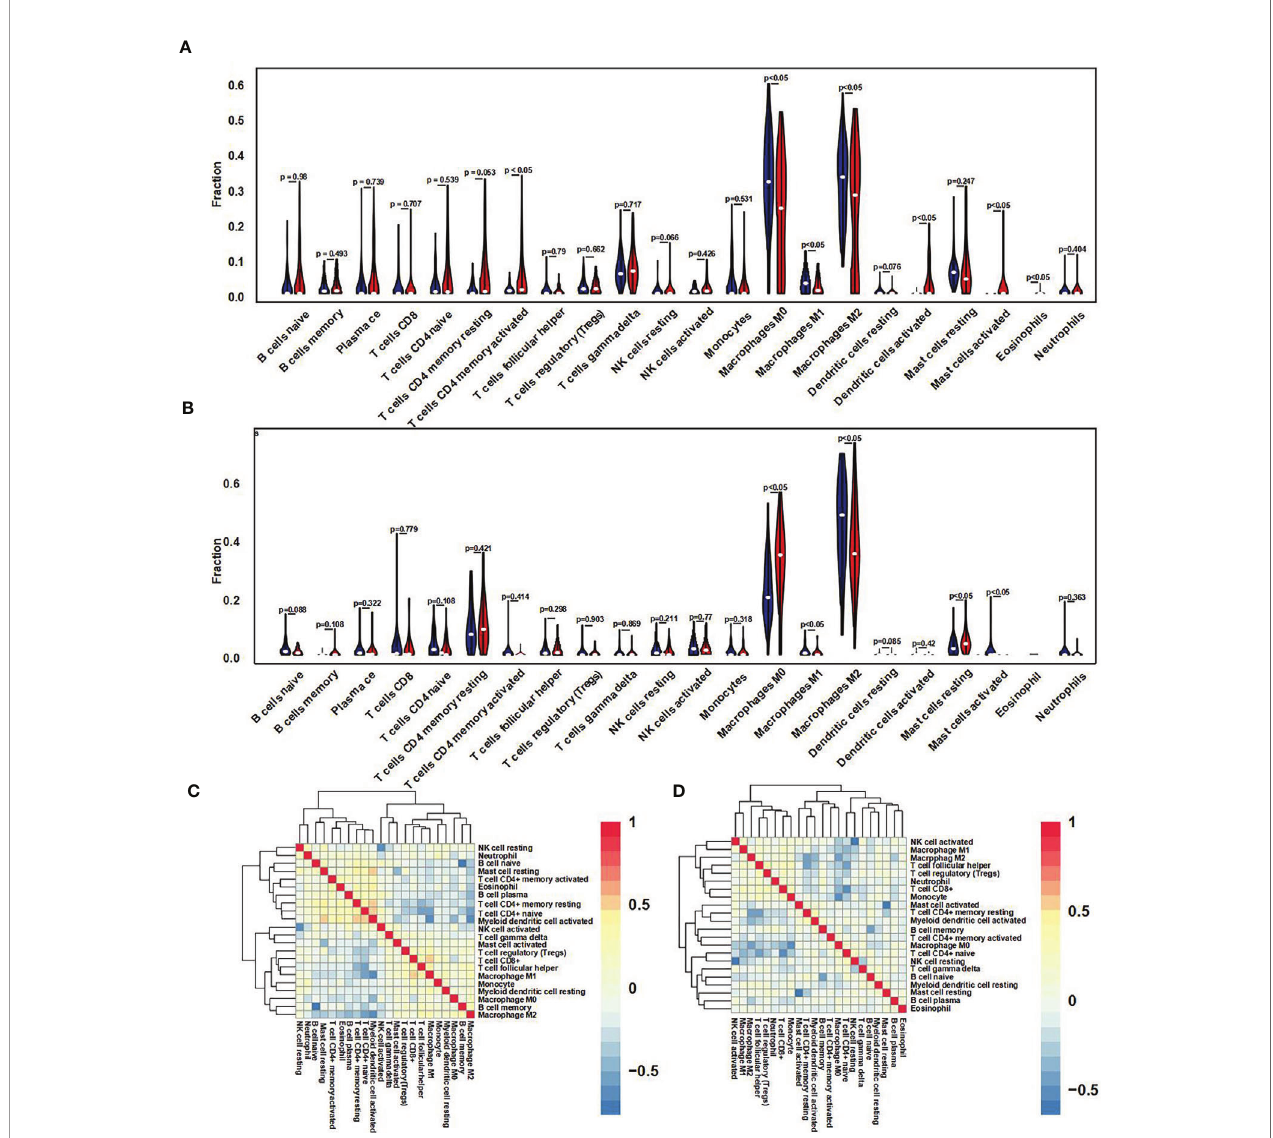
FIGURE 6 | Immune cell in fi ltration difference and correlation analysis. (A) Using the CIBERSORT package, the LM22 algorithm was used to calculate the difference in expression of 22 immune cells in the GNG12 high and low expression groups in the 103 osteosarcoma samples in the GEO set. Blue represents the low expression group, and red represents the high expression group. (B) Violin diagram of the difference in expression of 22 immune cells in fi ltration between the high and low expression groups of GNG12 in 101 osteosarcoma samples in the TARGET set. Blue represents the low expression group; red represents the high expression group. (C) Correlation heat map of 22 immune cells in the GEO set. (D) Correlation heat map of 22 immune cells in the TARGET set. The p -value represents the signi fi cance of the difference; p < 0.05 is considered a signi fi cant